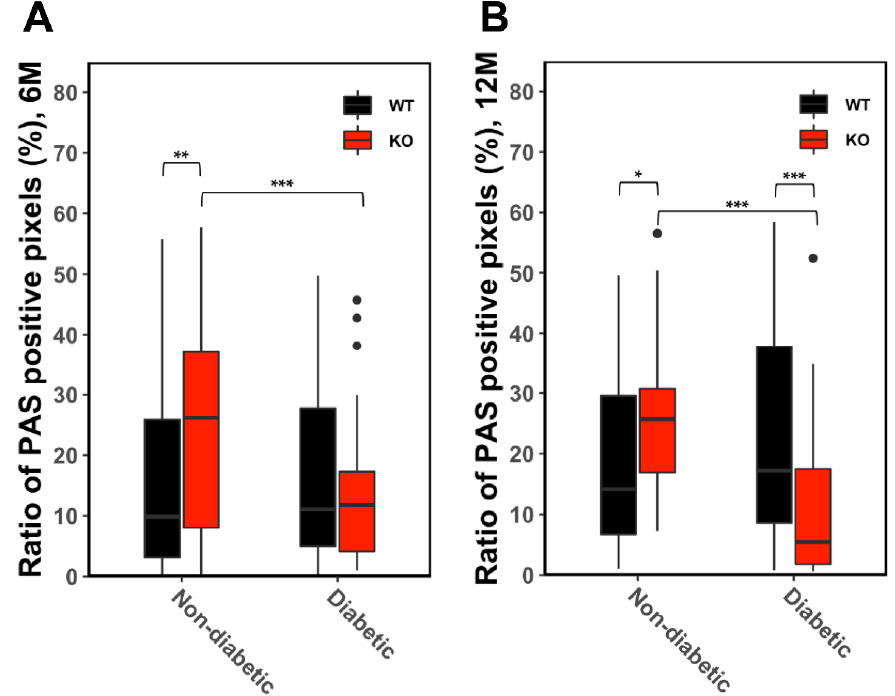
Figure 5. Glycogen content in the extrafocal liver tissue. Illustrative box plots represent glycogen content as PAS positive proportion of the liver section after six months ( A ). Hepatocytes of non-diabetic wild type (WT) mice stored significantly less glycogen than ChREBP-knockout (KO) mice. Non-diabetic KO-mice stored significantly more glycogen than diabetic KO mice. After 12 months ( B ), non-diabetic wild type mice (WT) also stored significantly less glycogen than ChREBP-knockout mice (KO). Hepatocytes of diabetic WT mice revealed significantly more glycogen than diabetic KO mice. Non-diabetic KO-mice stored significantly more glycogen than diabetic KO mice. * p < 0.05; ** p < 0.01; *** p < 0.001.